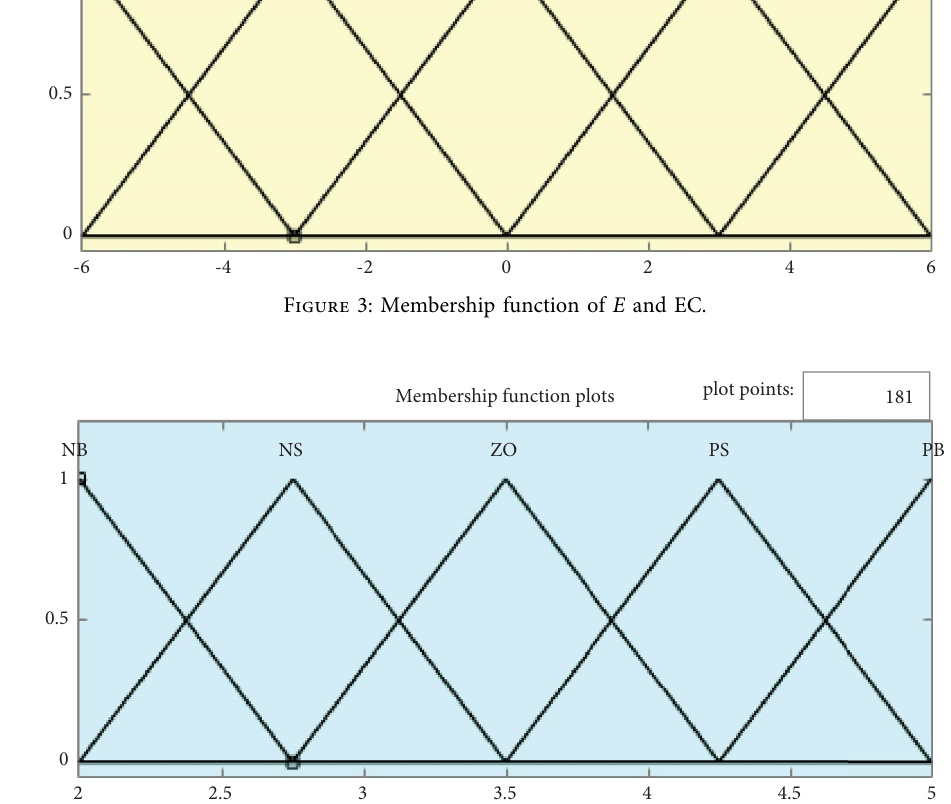
Figure 4: Membership function ∆ k Table 1: Fuzzy rules table ∆ k